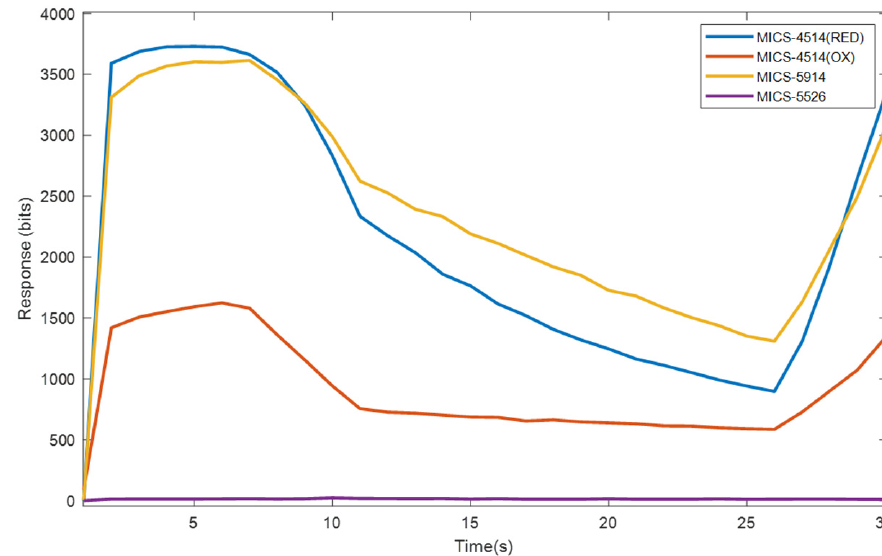
Figure 8. E-nose response to a sample of hydrogen peroxide.